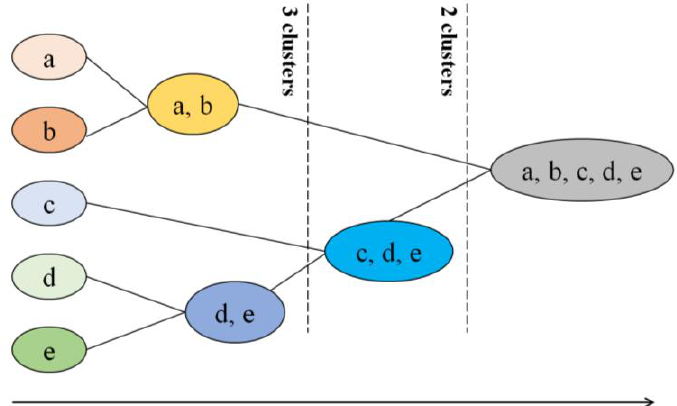
Figure 3. Schematic of Hierarchical clustering algorithm.